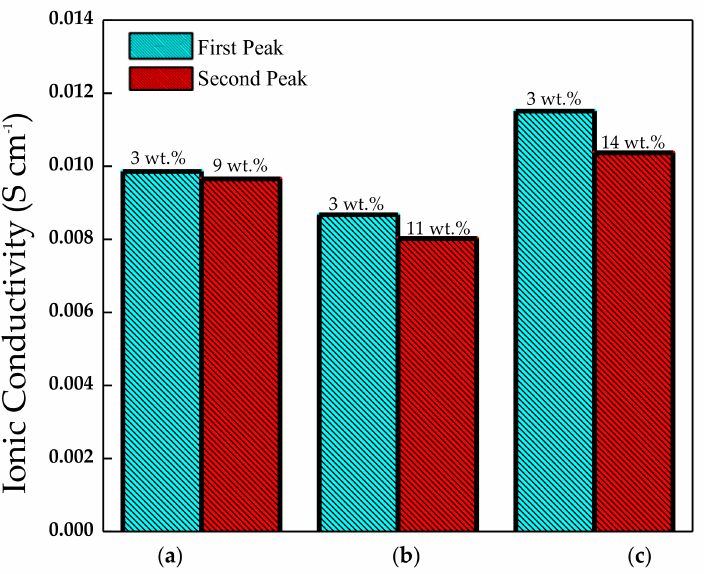
Figure 3. Room temperature conductivity peaks of composite gel polymer electrolyte films vs filler content: ( a ) nano-sized MgO, ( b ) micro-sized MgO, and ( c ) nano-sized SiO 2 . Prepared from data in